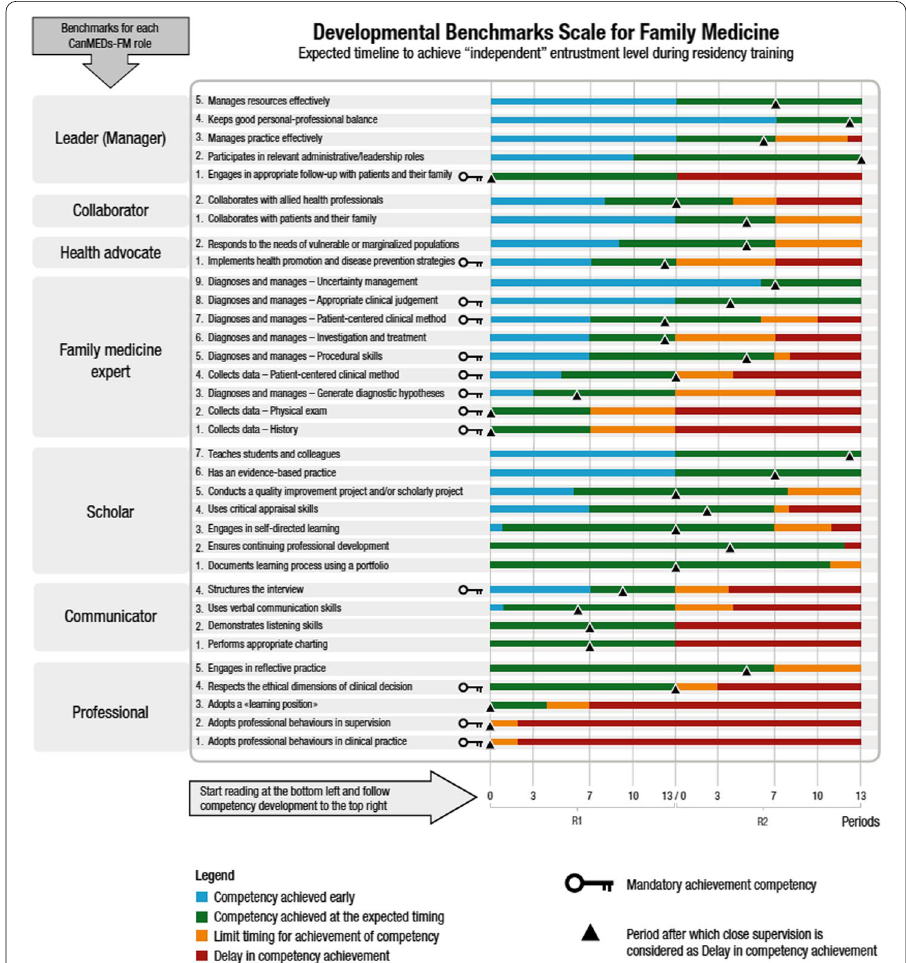
Fig. 3 Expected timeline to achieve “Independent” entrustment level during residency training ( © Faculty of Medicine, Laval